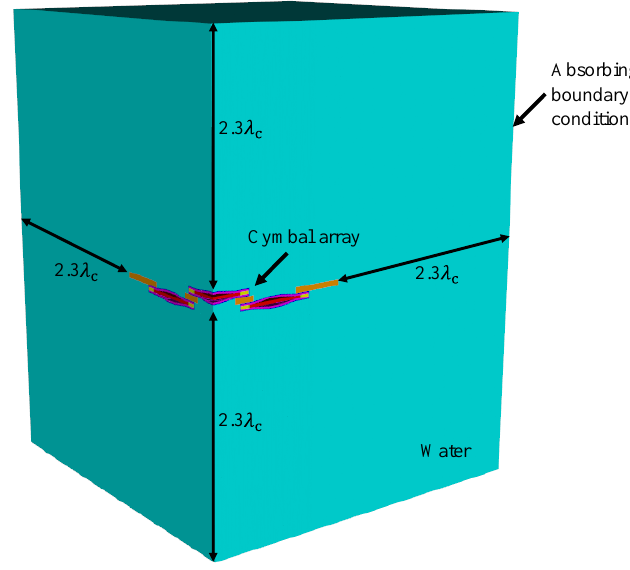
Figure 13. Finite element model of the immersed 3 × 3 cymbal array.